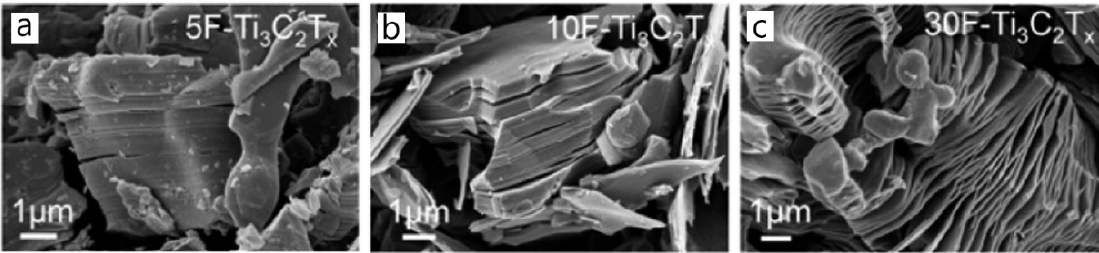
Figure 7. SEM images of the MXene structures synthesized using different etchant concentration: ( a ) 5 wt% HF; ( b ) 10 wt% HF; ( c ) 30 wt% HF. Reprinted with permission from [57]. Copyright © 2017 American Chemical Society.